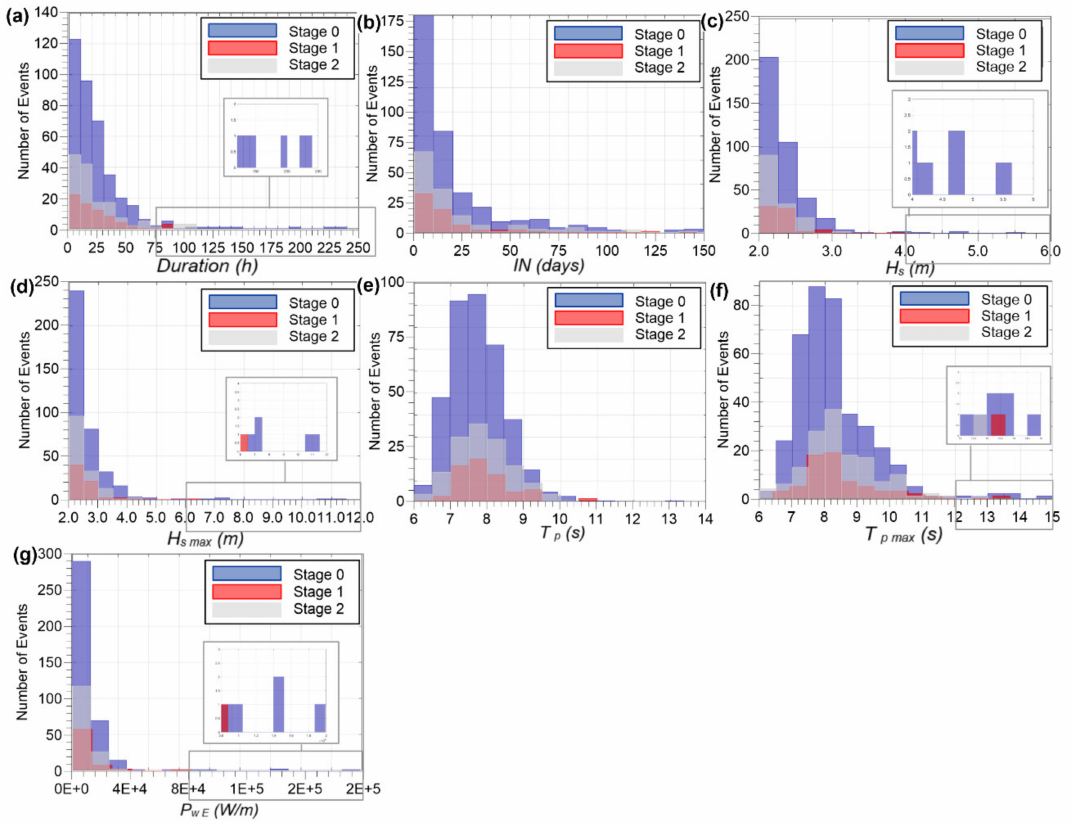
Figure 16. Histograms showing the extreme wave parameters for Stage 0 (blue), Stage 1 (red), Stage 2 (grey); ( a ) Duration; ( b ) IN (storm cluster time intervals); ( c ) H s (significant wave height); ( d ) H s max (maximum significant wave height); ( e ) T p (peak period); ( f ) T p max (maximum peak period); ( g ) P wE (mean wave power by